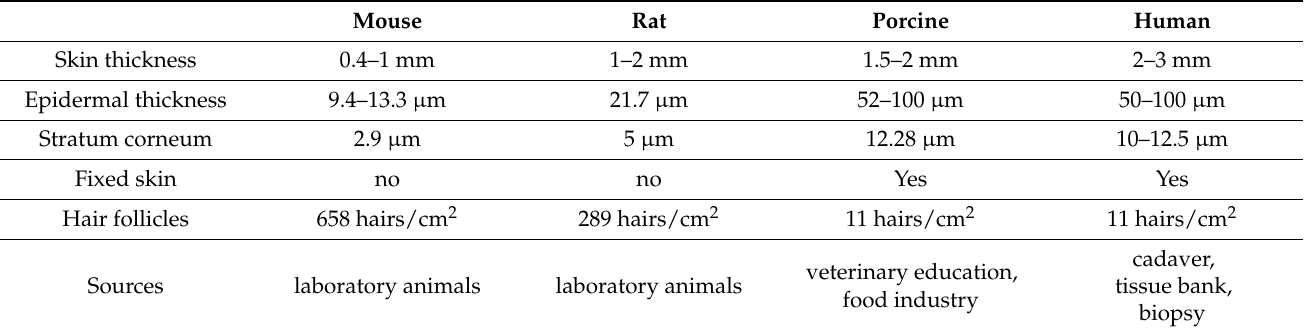
Table 2. Characteristics of skins of different species (modified from Liu et al., 2009 [32]). Mouse Rat